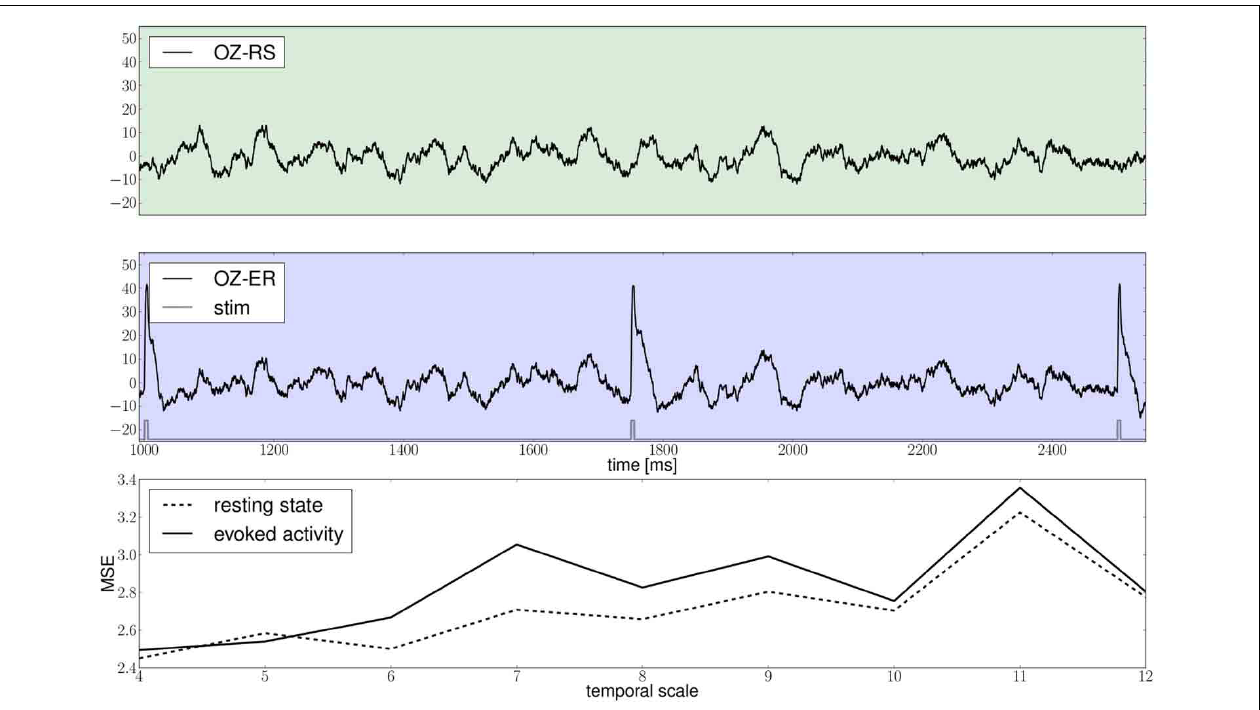
FIGURE 12 | The green and blue panels show EEG recordings from electrode Oz during the resting state , i.e., in the absence of stimulation and in the stimulated condition, respectively, notice the slow damped oscillations after stimulus onset at a approximately 10Hz; the light gray